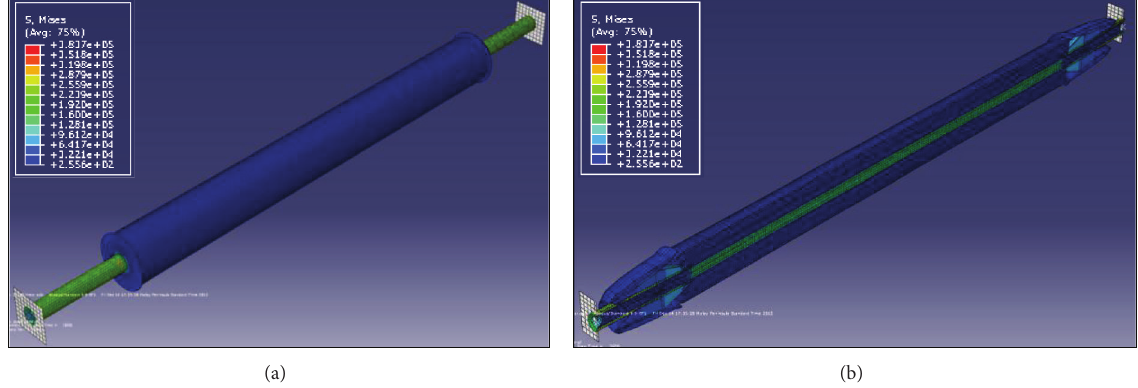
Figure 6: (a) 3D finite element structural model for BRBs, (b) deformed shape of BRBs after exposure to standard fire.